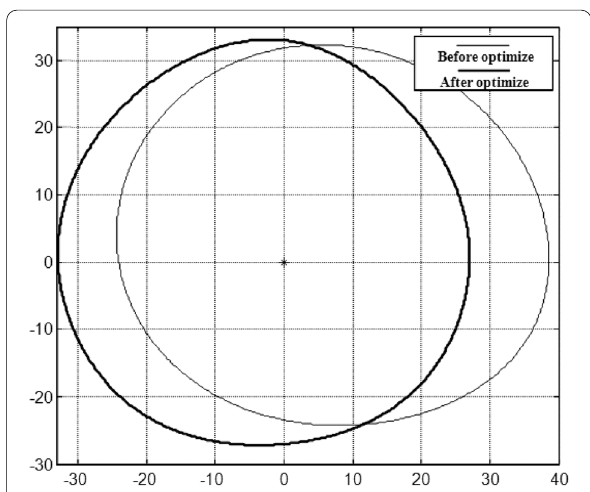
Figure 12 Tension pulley joint curve before and after optimization